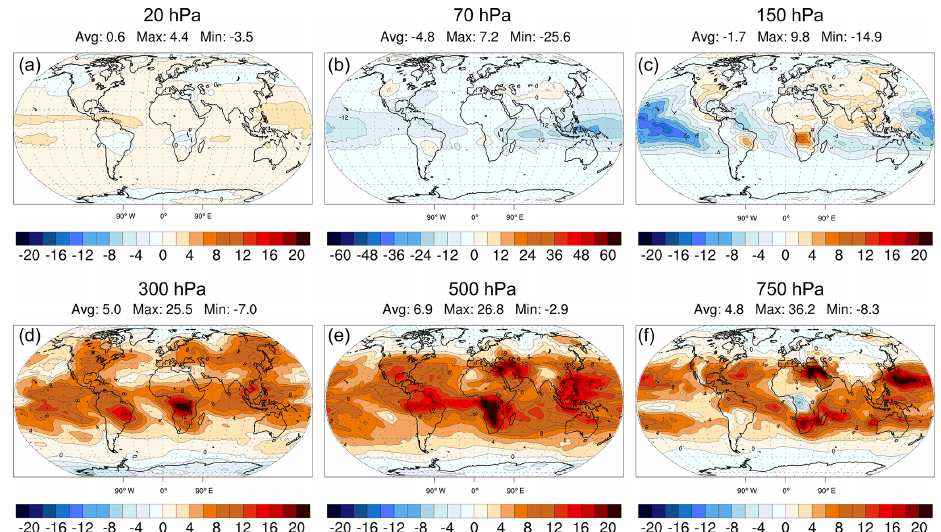
Figure 11. Relative average differences between MLS + L1a and MLS + L2a (MLS + L1a minus MLS + L2a divided by the corresponding O 3 values of the control simulation in Fig. 6) for July 2010. Same plots as in Fig.